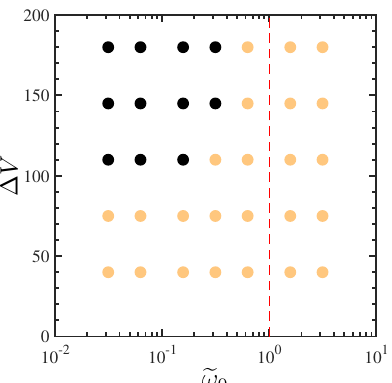
Figure 17. A frequency–voltage diagram for AC electroconvection of a binary symmetric electrolyte ( D − / D + = 1). Each symbol corresponds to a different pair of oscillation frequency and voltage. A symbol is dark when the maximum induced velocity exceeds the unit diffusion velocity u diff . The vertical dashed line corresponds to the RC